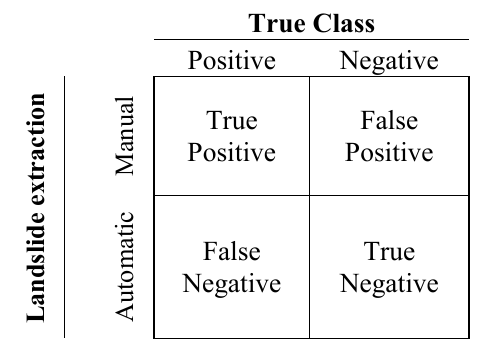
Figure 9. Contingency table 2 × 2 (modified from